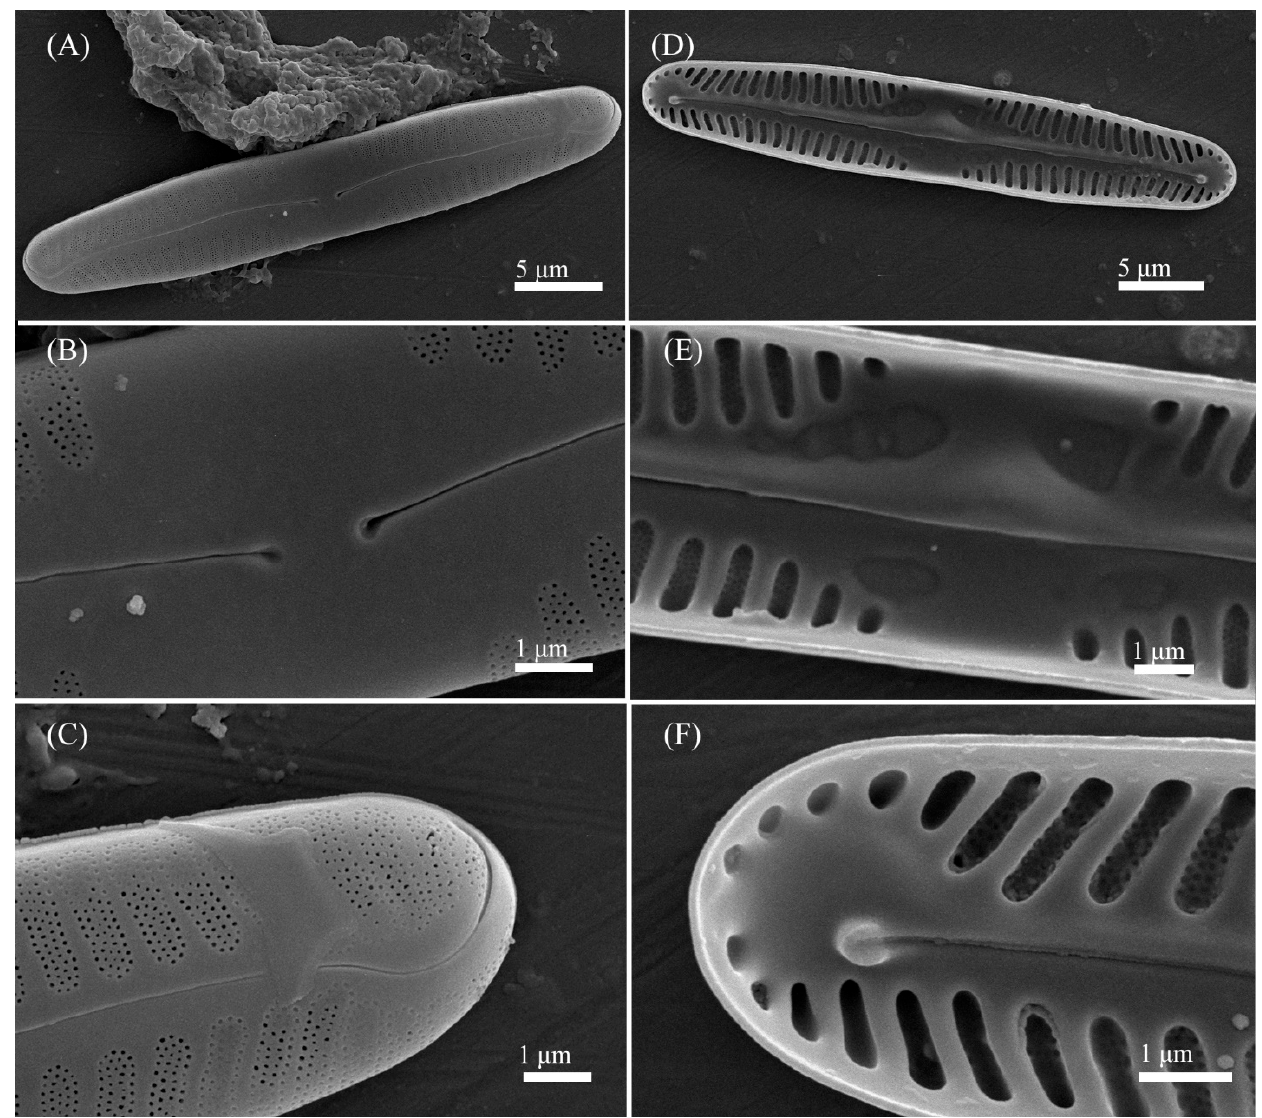
Figure 8. Pinnularia microgibba Kezlya, Maltsev, Krivova et Kulikovskiy sp. nov. Strain VP289 sample No. 07047. Scanning electron microscopy. ( A – C ) External views. ( D – F ) Internal views. ( A , D ) The whole valve. ( B , E ) Central area. ( C , F ) Valves ends. Arrows indicate the ghost striae.